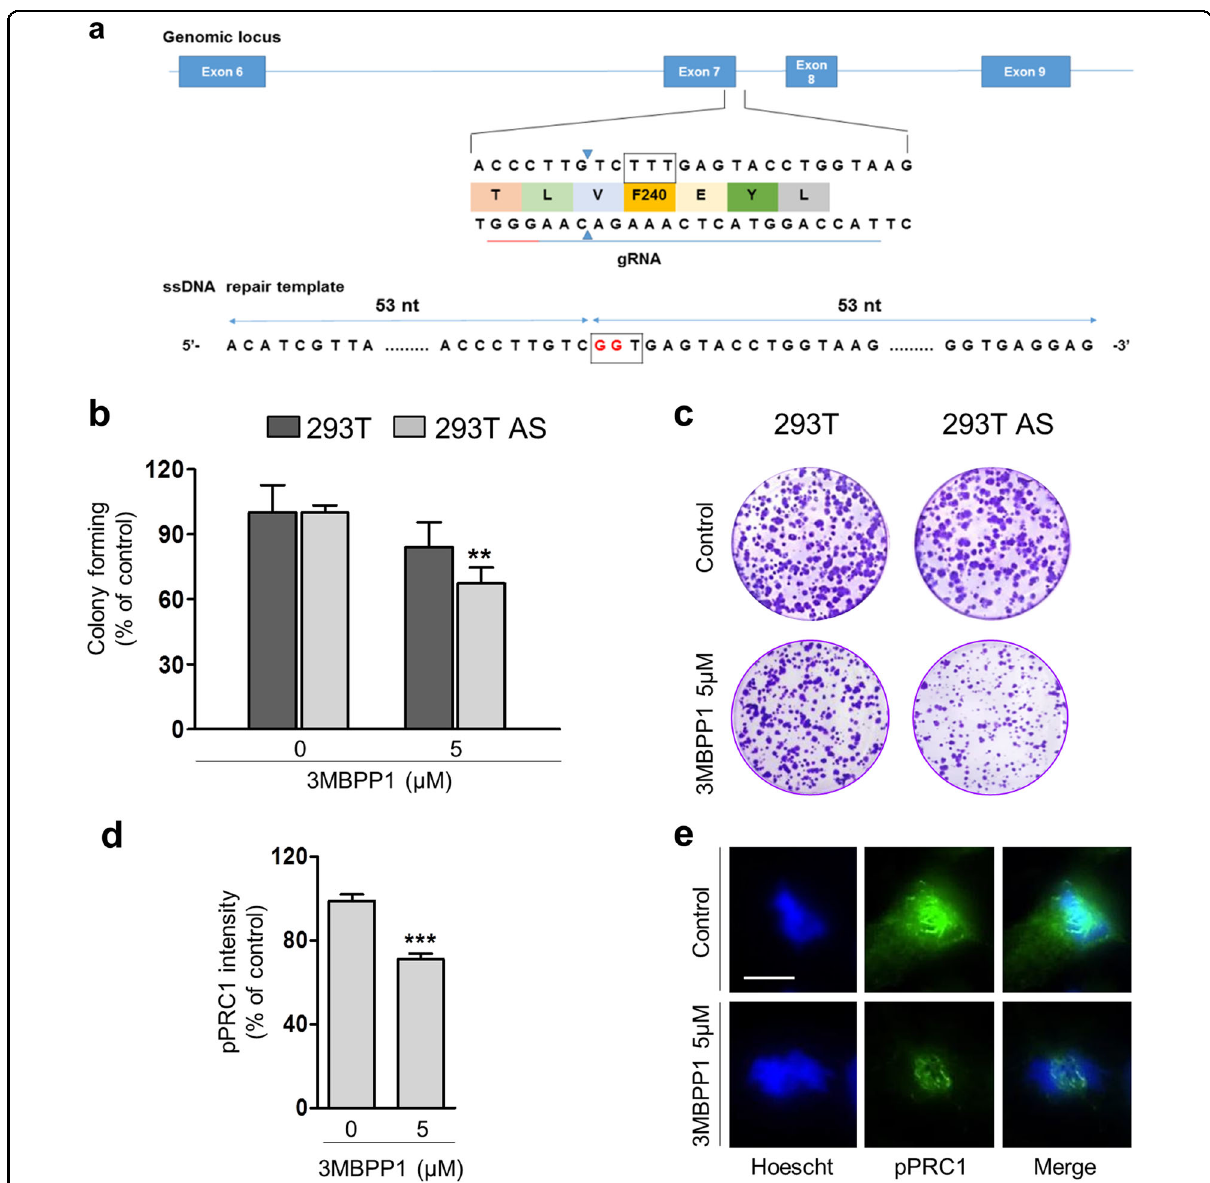
Fig. 4 Generation of a clonal 293T analog-sensitive (AS)-CDK16 cell line by CRISPR-Cas9. a Schematic representation of the human CDK16 locus showing the target site used for CRISPR/Cas-mediated genome editing in 293T cells and the ssDNA used as repair template. ( b , c ) Colony formation assay of 293T and 293T AS-CDK16 cells grown in the absence or presence of 3MBPP1. The columns represent the means ± SEMs of 7 independent experiments performed in triplicate. ** P < 0.01 vs nontreated cells, Mann – Whitney test. ( d, e ) 293T AS-CDK16 cells were synchronized and treated with 3MBPP1. After 6 h, cells were fi xed and immunostained with a phospho-T481-PRC1 (pPRC1) antibody. Three independent experiments were performed, and 150 – 200 cells were analyzed per condition. The graph shows the results of one representative experiment, and the columns represent the means ± SEMs. *** P < 0.001 vs control, Student ’ s t